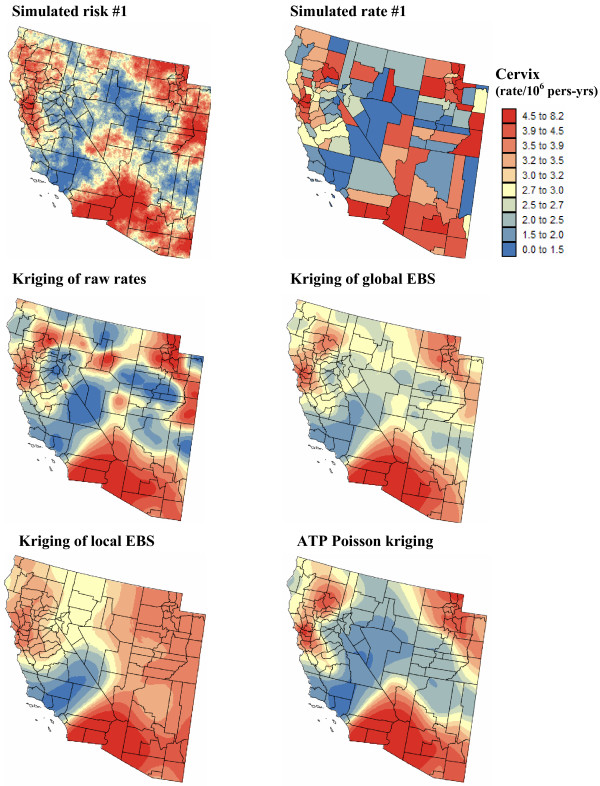
Simulated cervix cancer risk map and the results of the different forms of area-to-point kriging. The fill color represents mortality risk per 100,000 person-years simulated by sequential Gaussian simulation and the results of the estimation using the following approaches: point kriging of raw rates, point kriging of global and local empirical Bayesian smoothed (EBS) rates, and area-to-point (ATP) Poisson kriging. The color legend applies to all the maps; the class boundaries correspond to the deciles of the histogram of original rates.